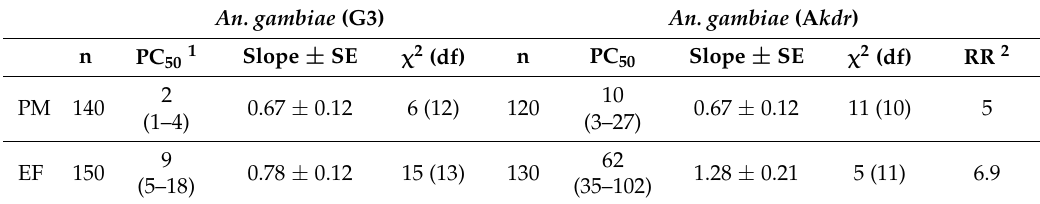
Table 3. Fourth-instar (headless) larvae paralytic effect of permethrin (PM) and etofenprox (EF). An. gambiae (G3) An. gambiae (A kdr